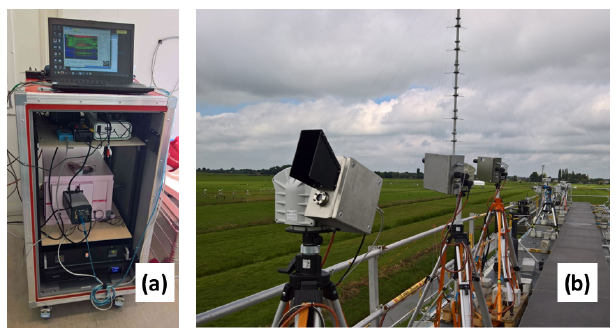
Figure 1. The IMPACT instrument installed during CINDI-2. (a) Indoor parts integrated into a 19 (cid:48)(cid:48) rack. (b) Telescope unit on top of the container deck (foreground). Next to IMPACT is the IUP- Bremen 2-D MAX-DOAS instrument (background) used for com- parison in Sect.